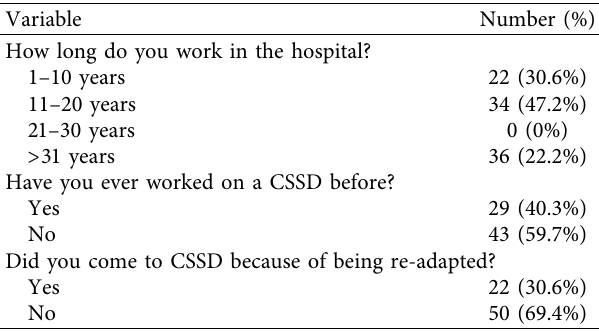
Table 2: Professional profile of the participants ( n �